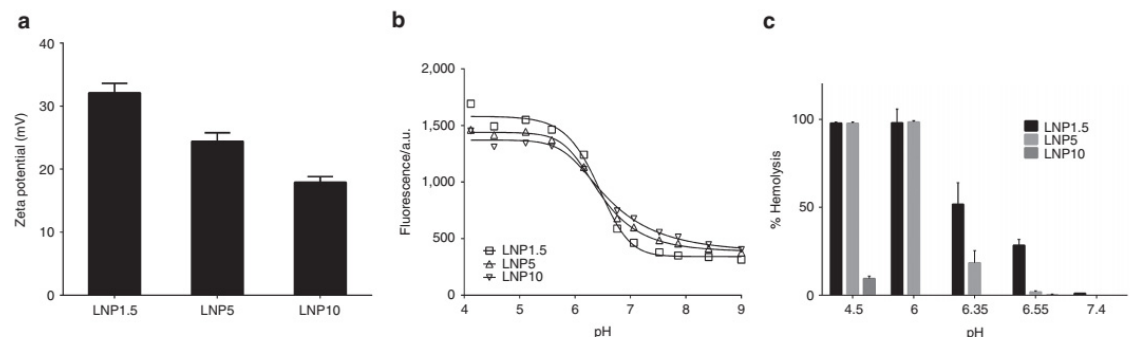
Figure 3. Increasing PEO density shielded the surface charge and reduces haemolytic activity on the LNPs. ( a ) Zeta potential measured at pH 5.5 for LNP1.5, LNP5, and LNP10 in RO/DI water. ( b ) The measurement of fluorescence (using 2-(p-toluidinyl) naphthalene-6-sulfonic acid sodium salts) at different pH range for LNP1.5, LNP5, and LNP10. The characteristic signal drop of fluorescent was observed which is attributed by pKa of IL ( c ) Haemolytic activity for LNP1.5, LNP5, or LNP10 across different pH ranges. The relative haemolysis is compared with complete haemolysis (100%) which is induced using Triton X-100 at 2% is shown. Adapted from ref. [70], Mol. Ther. Nucleic Acids 2014.